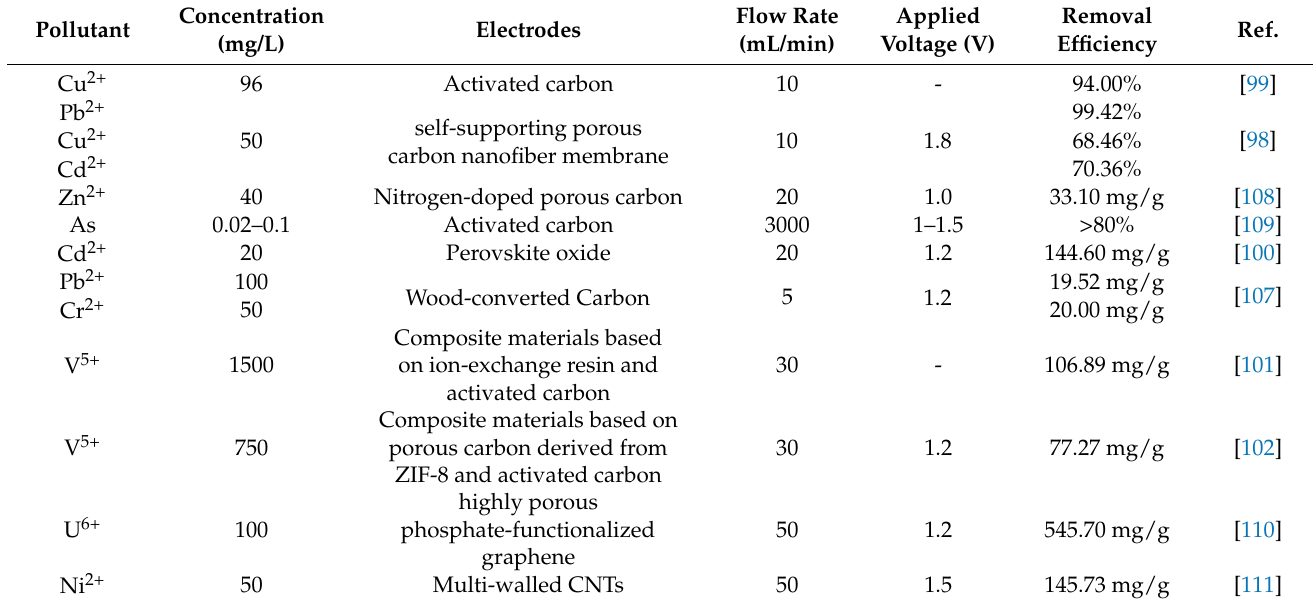
Figure 5. ( a ) The process of electro-assisted adsorption of Zn 2+ from aqueous solution using activated carbon cloth as electrode in batch-flow mode [97]. Copyright 2019, American Chemical Society. ( b ) Controlled synthesis of ZnO-modified N-doped porous carbon nanofiber membrane for removal of heavy metal ions by CDI [98]. Copyright 2022, Elsevier. ( c ) Schematic illustration for preparation process of FeMnO 3 and FeMnO3@PPy [100]. Copyright 2022, Elsevier. ( d ) The schematic of CDI assembly for metal removal [105]. Copyright 2015, Elsevier. Table 2. Removal efficiency of heavy metal ions by